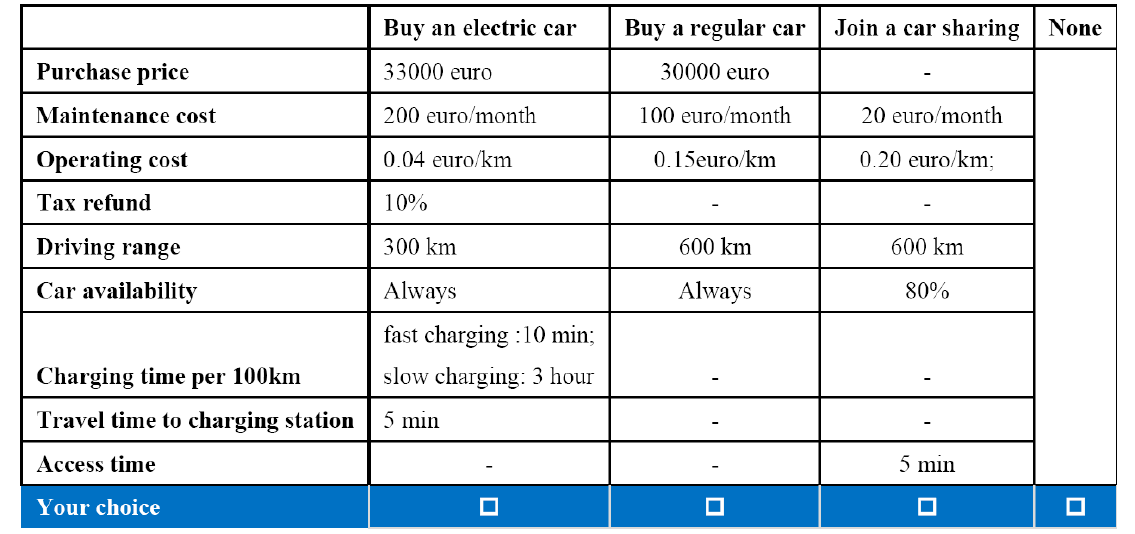
Figure 1. An example of the choice experiment of mobility tools.